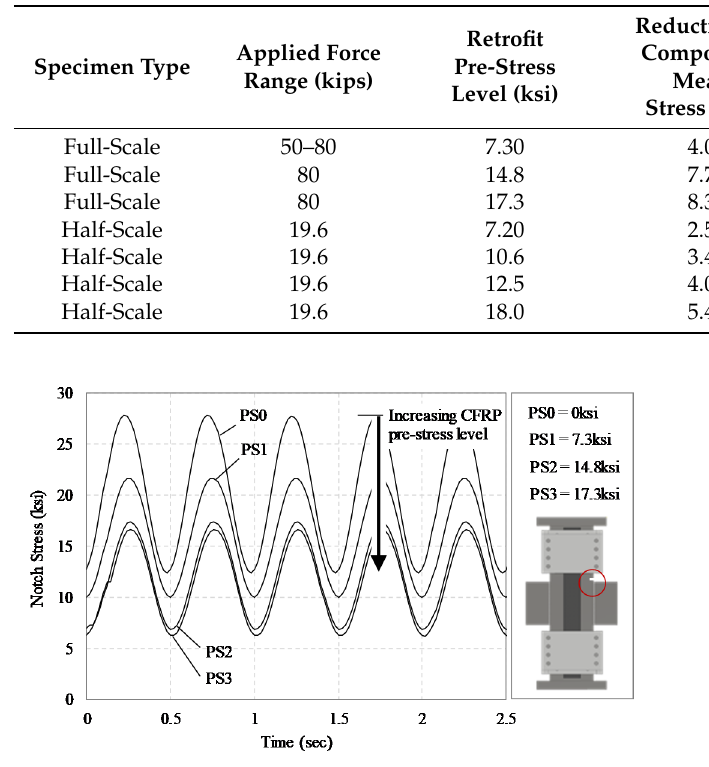
Figure 31. Effect of CFRP pre-stressing on notch local stress history.